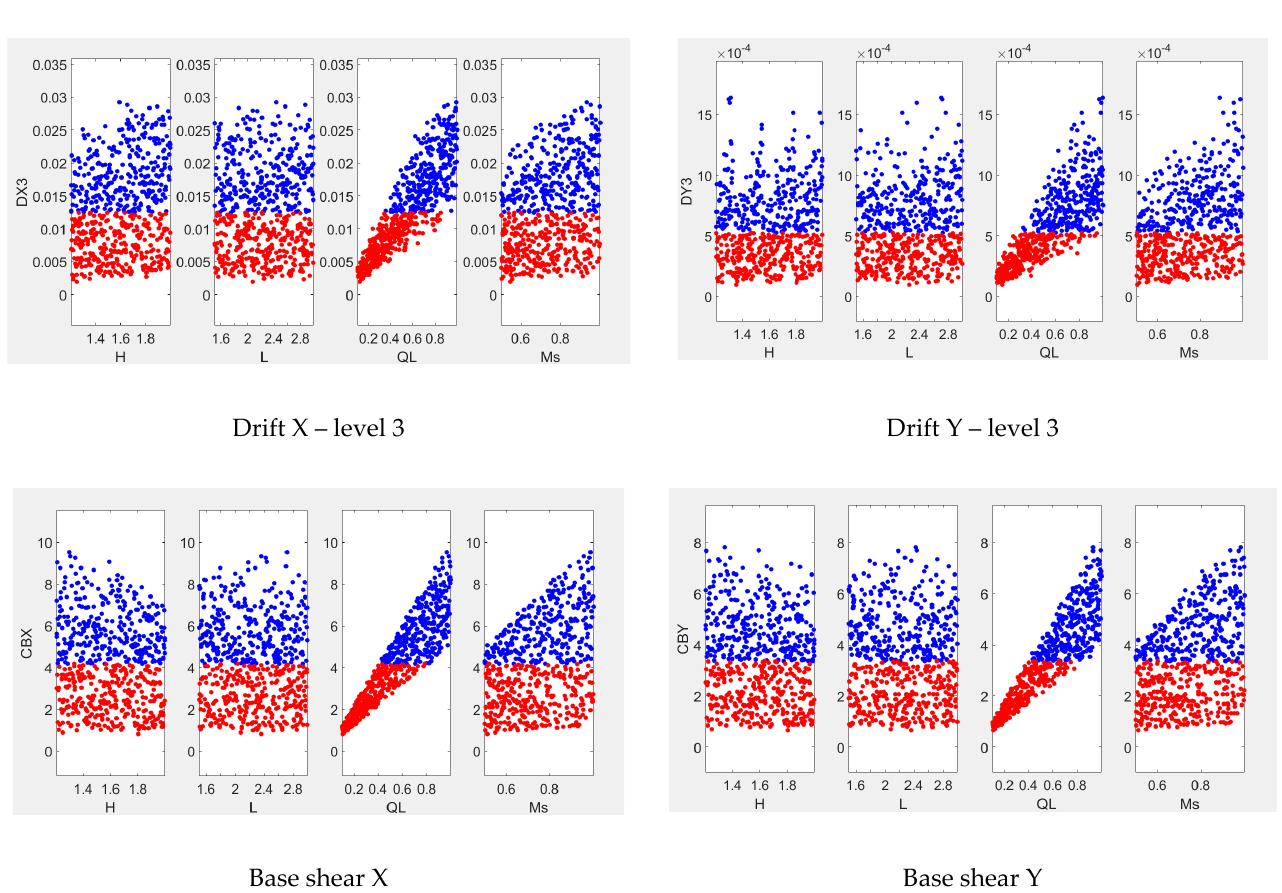
Figure 12. Results of sensitivity analysis for CBZ3S4 models without bracing towers racks models.